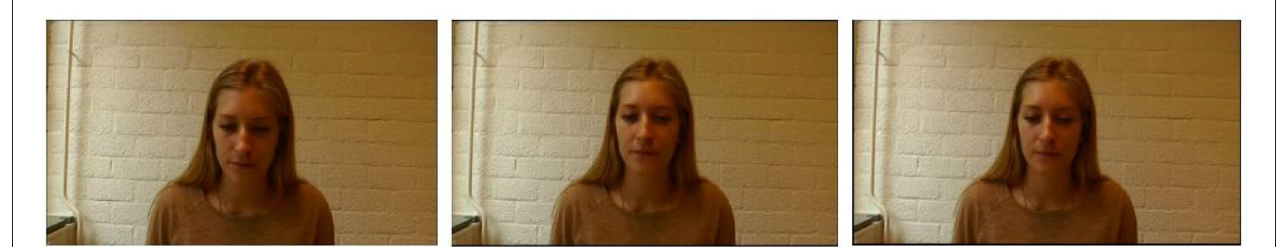
FIGURE 3 | A few still images from an original addressee during BOP